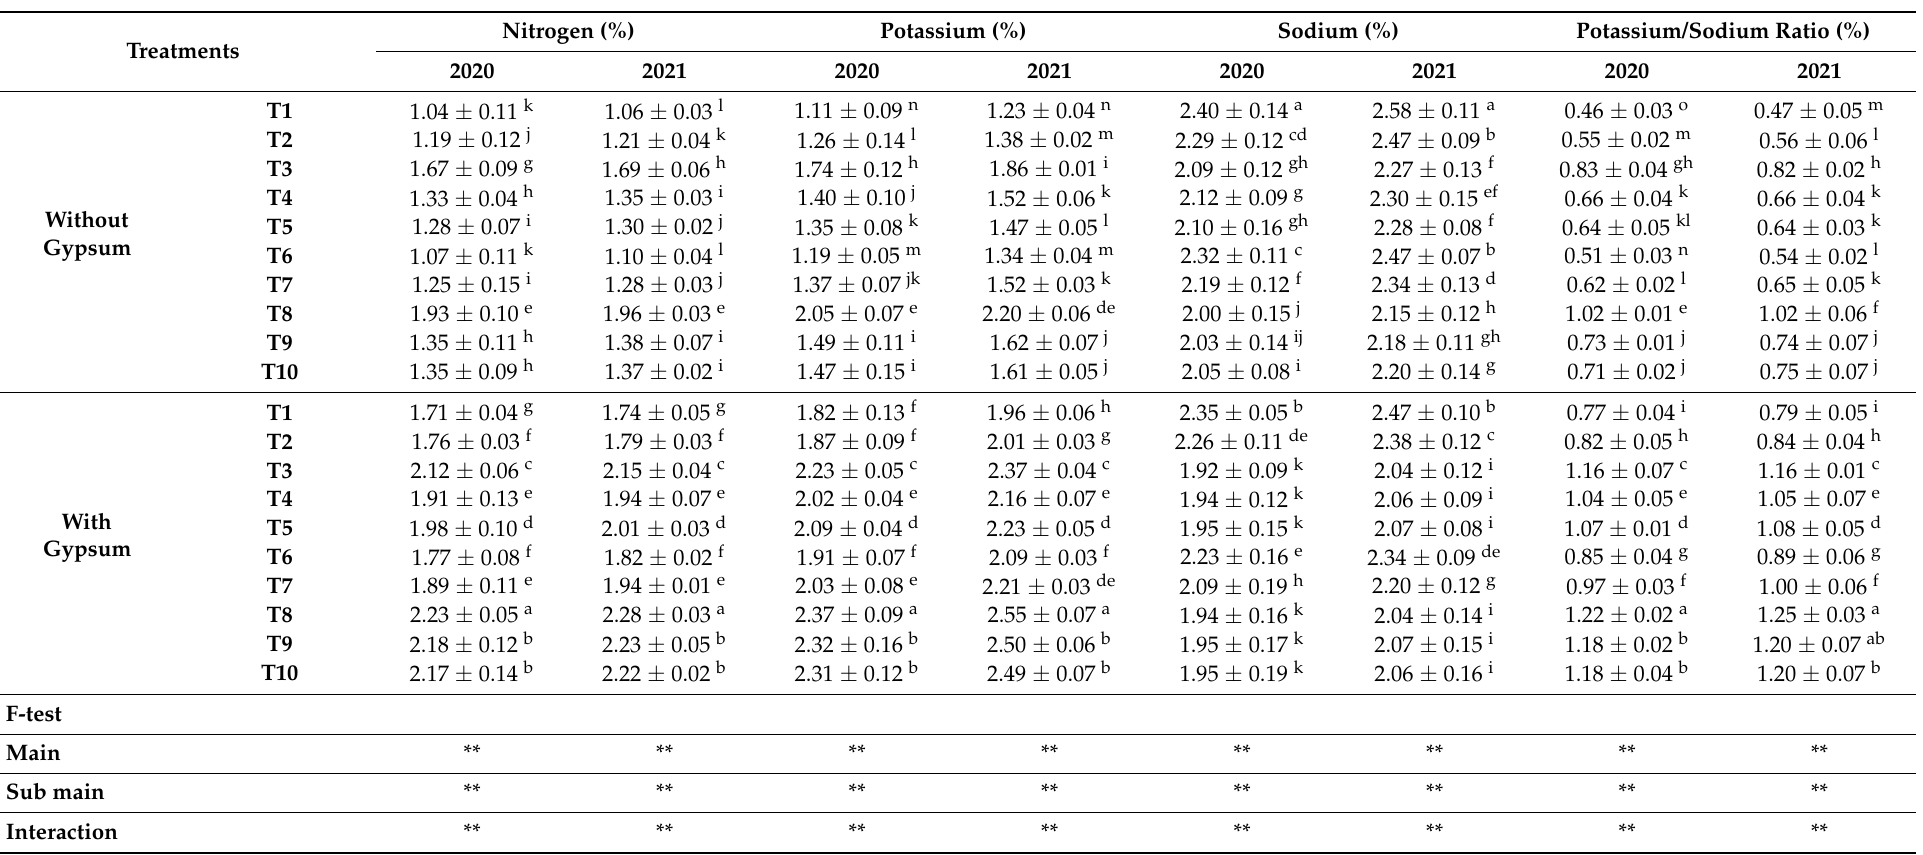
Table 4. Combined effects of gypsum, and bio-priming with PGPR and different levels of chitosan (0, 25, 50, 75, and 100 mg L − 1 ), on N, K + , Na + and the K + /Na + ratio of leaves in maize plants at 60 days from sowing during the 2020 and 2021